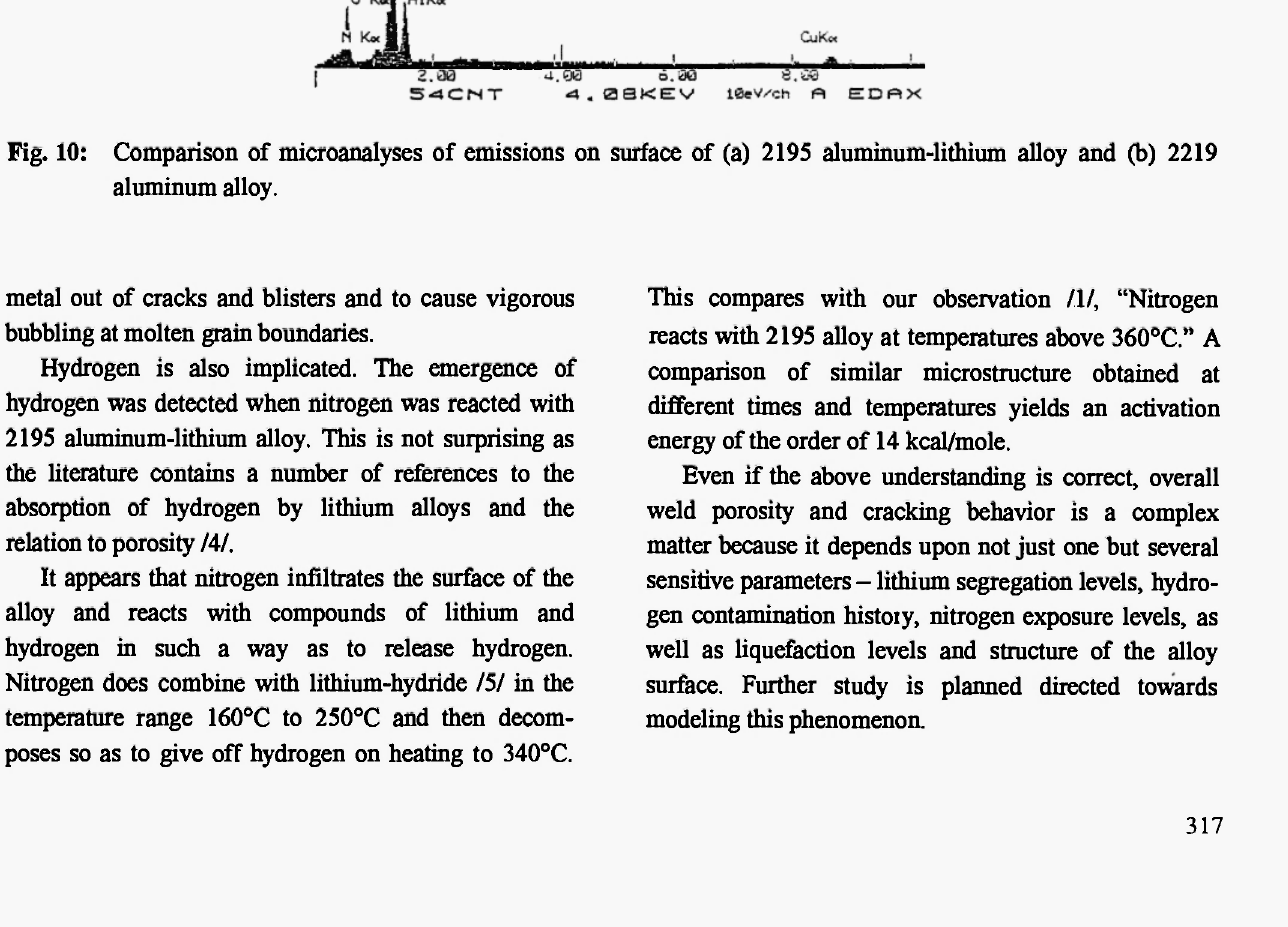
Fig. 10: Comparison of microanalyses of emissions on surface of (a) 2195 aluminum-lithium alloy and (b) 2219 aluminum